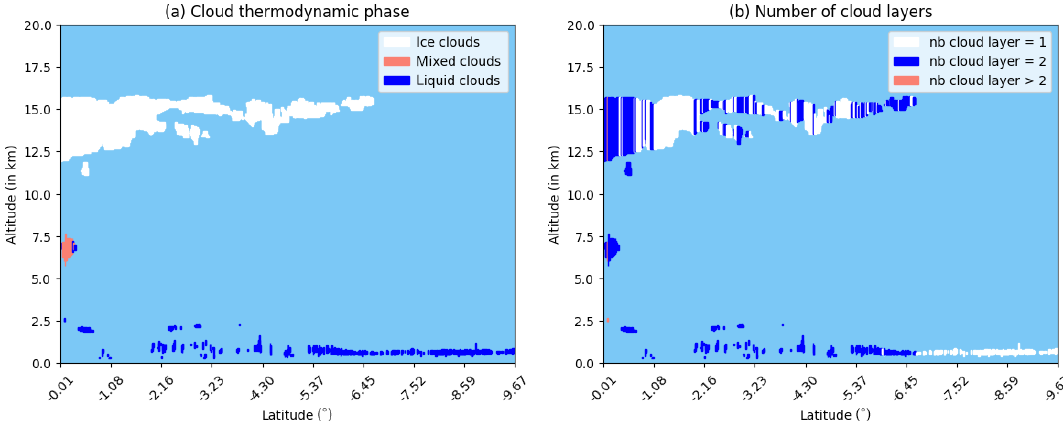
Figure 2. An example 2B-CLDCLASS-lidar curtain (2008183012329_11573_CS_2B-CLDCLASS-LIDAR_GRANULE_P_R04_E02.hdf): (a) cloud thermodynamic phase for each detected cloud layer (ice, liquid or mixed) and (b) the number of cloud layers identified after merging cloud layers with a vertical separation distance less than 3km.